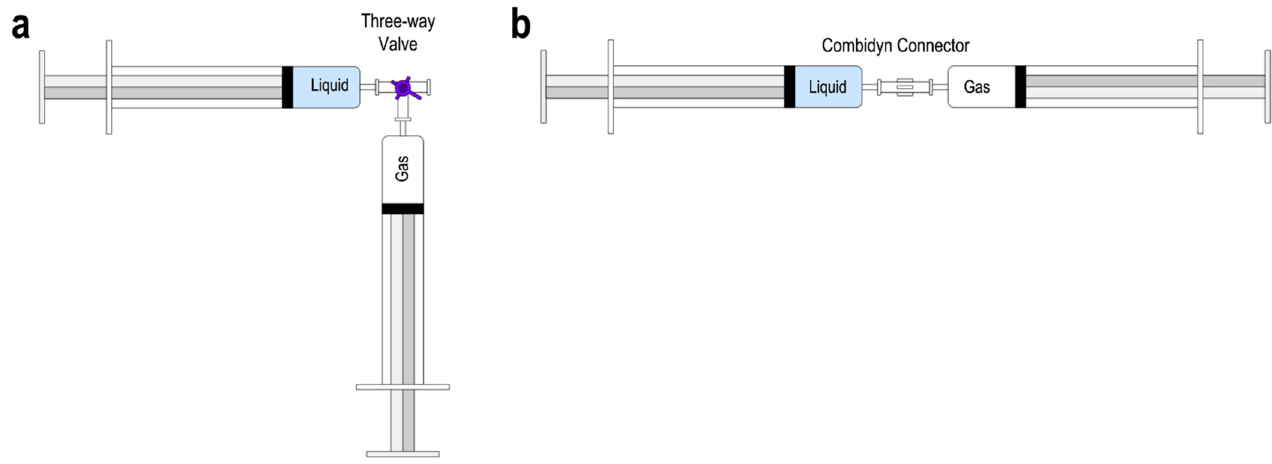
Figure 1. Methods of producing PCFs. 10 mL and 5 mL syringes are filled with the required amounts of room air and 1% v / v polidocanol solution, respectively. PCFs are formulated by pushing the liq- uid in and out of the syringes 10 times. ( a ) The Tessari (TSS) method. A three-way stopcock connects the syringes (the stopcock in this study is set at a 30° angle). ( b ) The double syringe system (DSS) method. Instead of a three-way stopcock, a Combidyn connector is